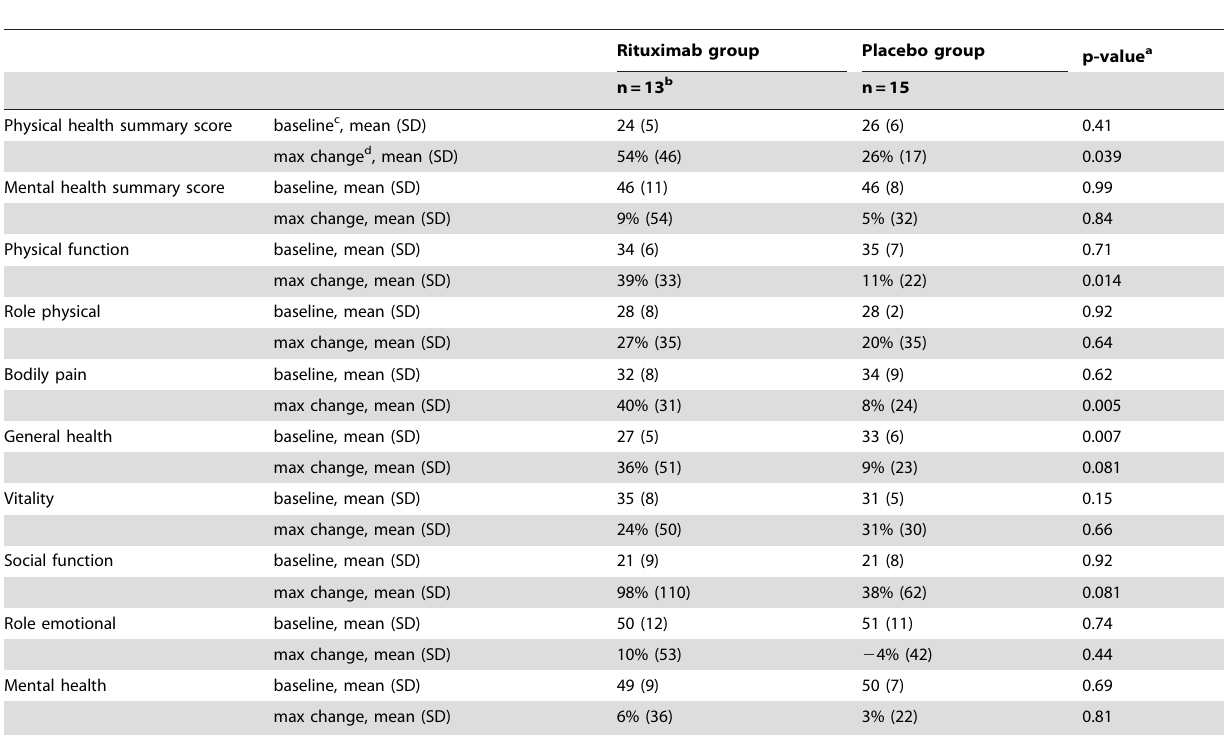
Table 4. SF-36 scores, baseline levels (0–100) and maximum changes (%) during follow-up, for patients in the Rituximab and Placebo